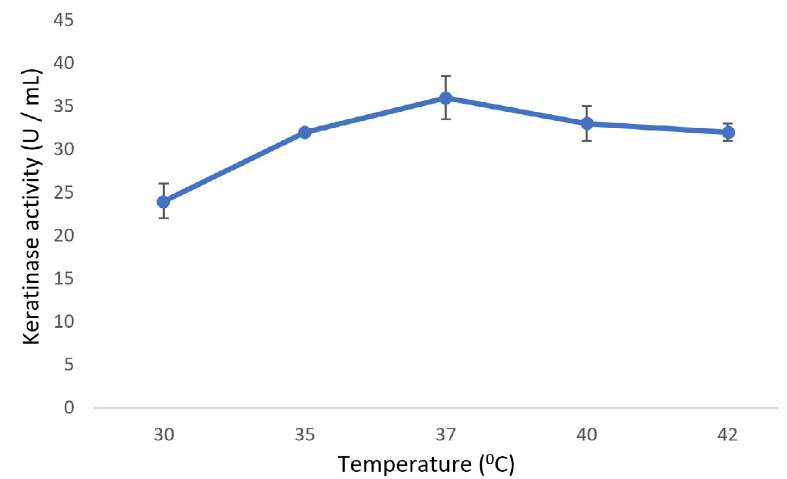
Fig. 2. Optimization of keratinase enzyme production at different pH.